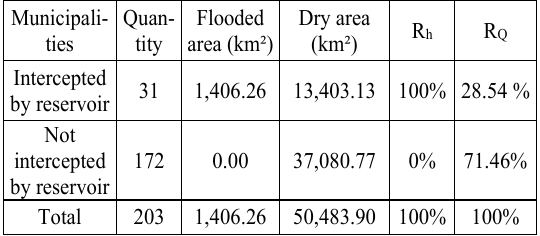
Table 2. Surface areas and contributions of municipalities to the Water Flow (Q) and head of water (h) of the Furnas hydroelectric power plant where R h = relative contributing area of municipalities to net falling height R Q = relative contributing area of municipalities to water